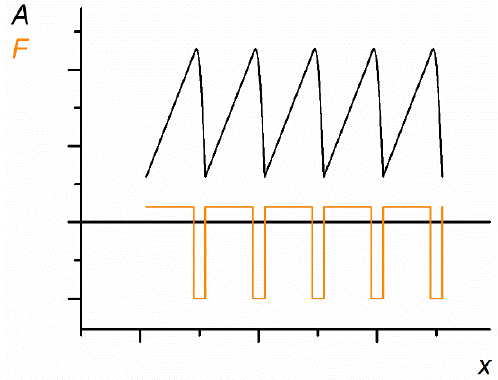
Figure 18. Schematic presentation of the energy and the force dependence on the position of an object moving as a result of the ratchet mechanism.